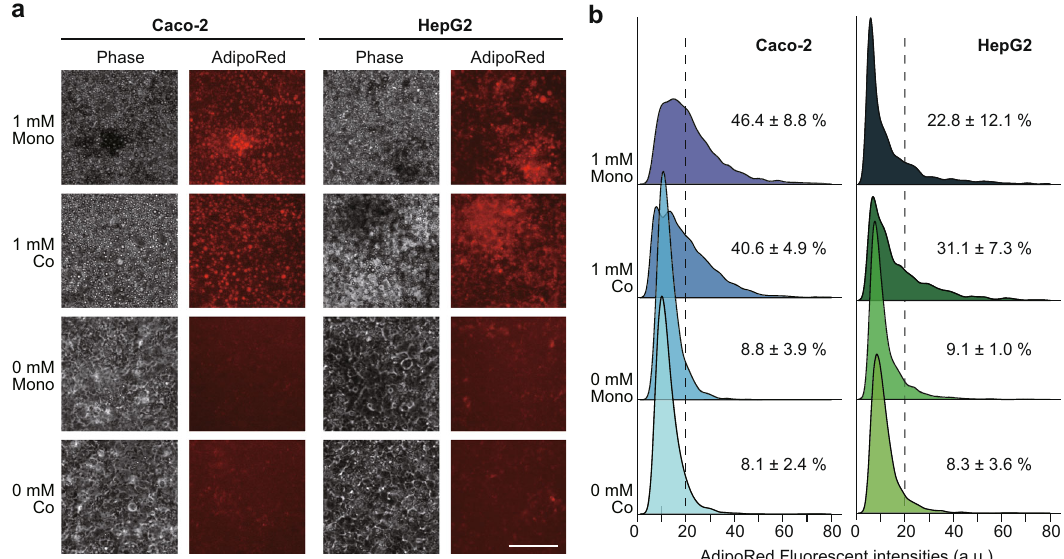
Fig. 3 Lipids accumulated in both Caco-2 and HepG2 cells after 7-day FFAs treatment. a Phase contrast and fl uorescent micrographs of Caco-2 and HepG2 cells treated with FFAs (0 and 1 mM) for 7 days stained with AdipoRed lipid fl uorescent dye. The scale bars represent 100 µ m. b Ridgeline plots to evaluate FFAs accumulation in individual cells [Caco-2 ( left ) and HepG2 ( right )] after FFAs treatment for 7 days. The p -values were estimated with the Tukey – Kramer test and are presented in Supplementary Tables S5, S6 for the Caco-2 and HepG2 cells, respectively. Cells with over 20 of AdipoRed fl uorescent intensity were considered as lipid accumulated cells. The data represent the mean ± standard deviation ( n =